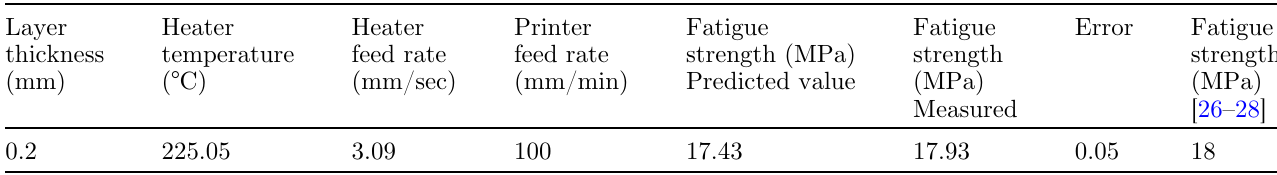
Table 6. Veri fi cation experiment. Layer